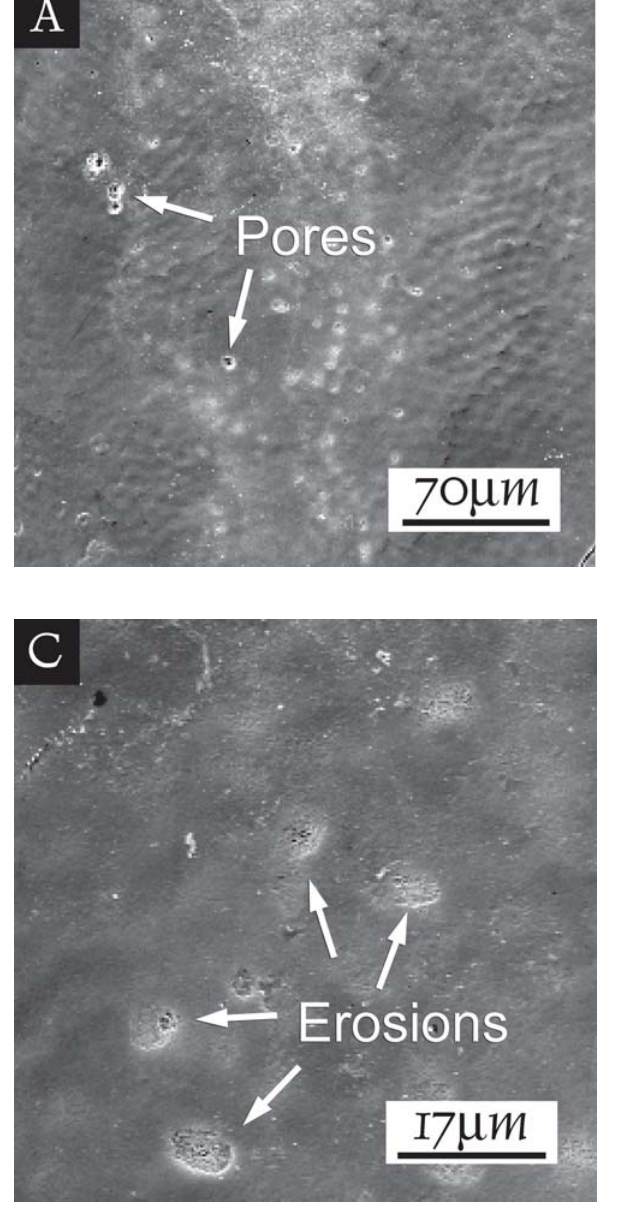
FIGURE 5- Photomicrographs of bleached enamel after 35% hydrogen peroxide applications at 500x (A and B) and 2000x magnifications (C and D): partial removal of the aprismatic layer, pores, depressions and